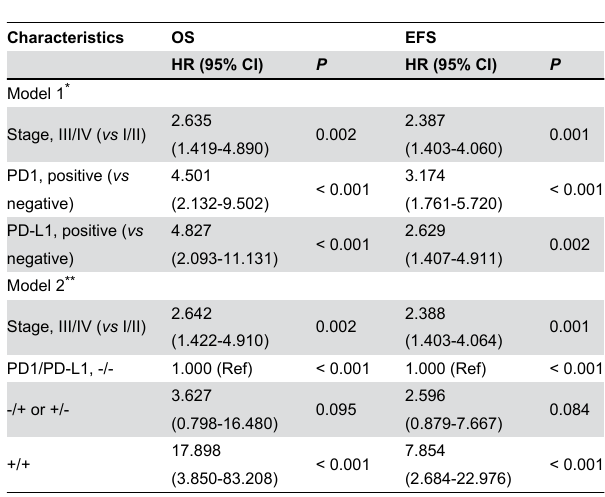
Table 4. Multivariate Cox regression analysis for overall survival and event-free survival of soft-tissue sarcoma